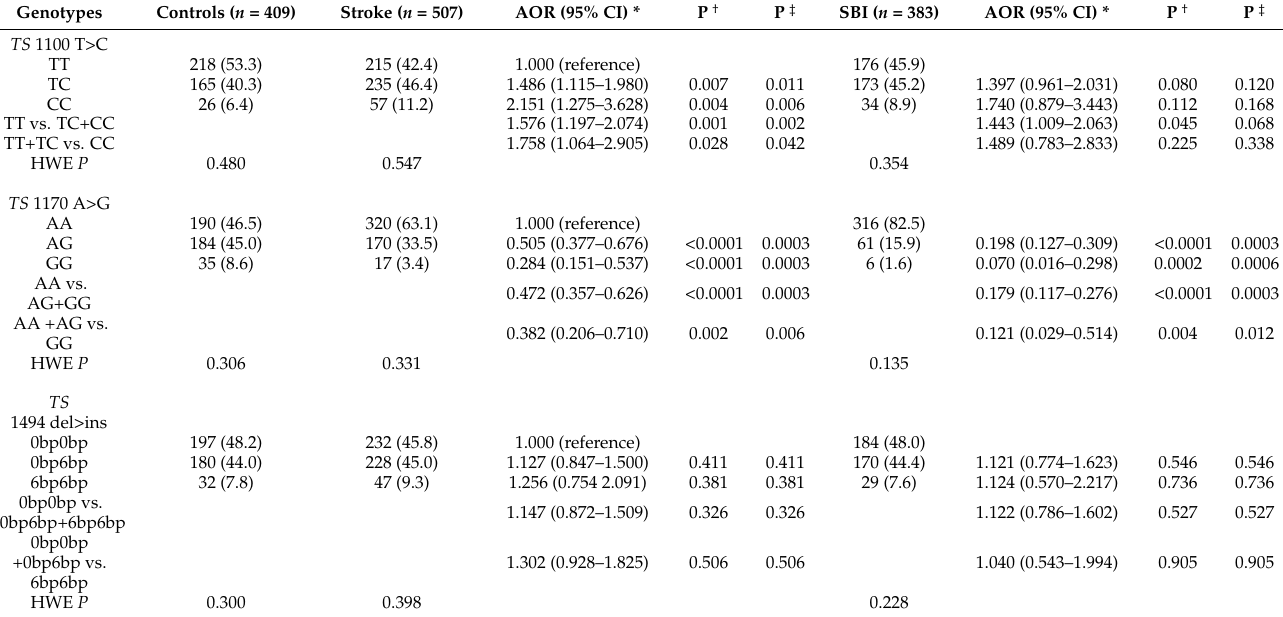
Table 2. Genotype frequencies of TS gene polymorphisms in control subjects, ischemic stroke patients, and silent brain infarction patients.